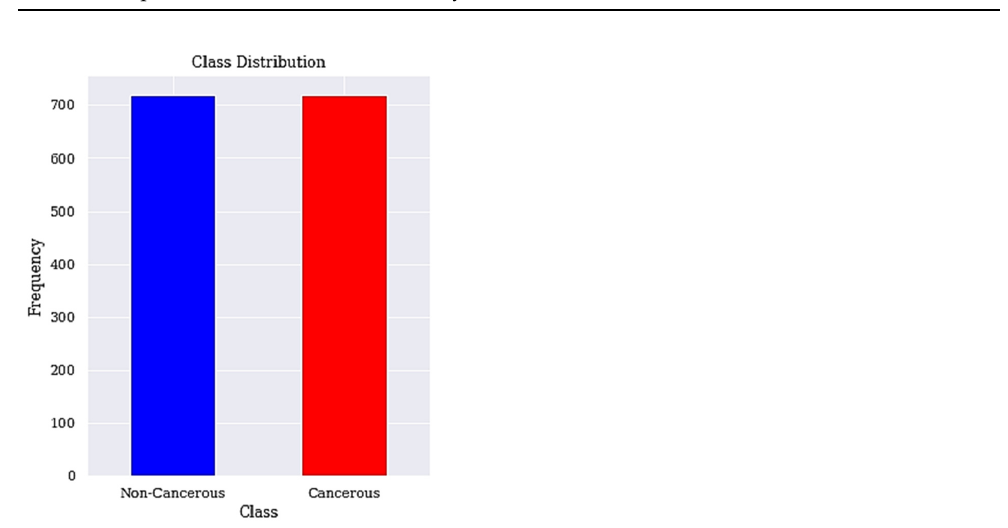
Figure 2. Balanced class distribution. The class distribution after resampling is shown